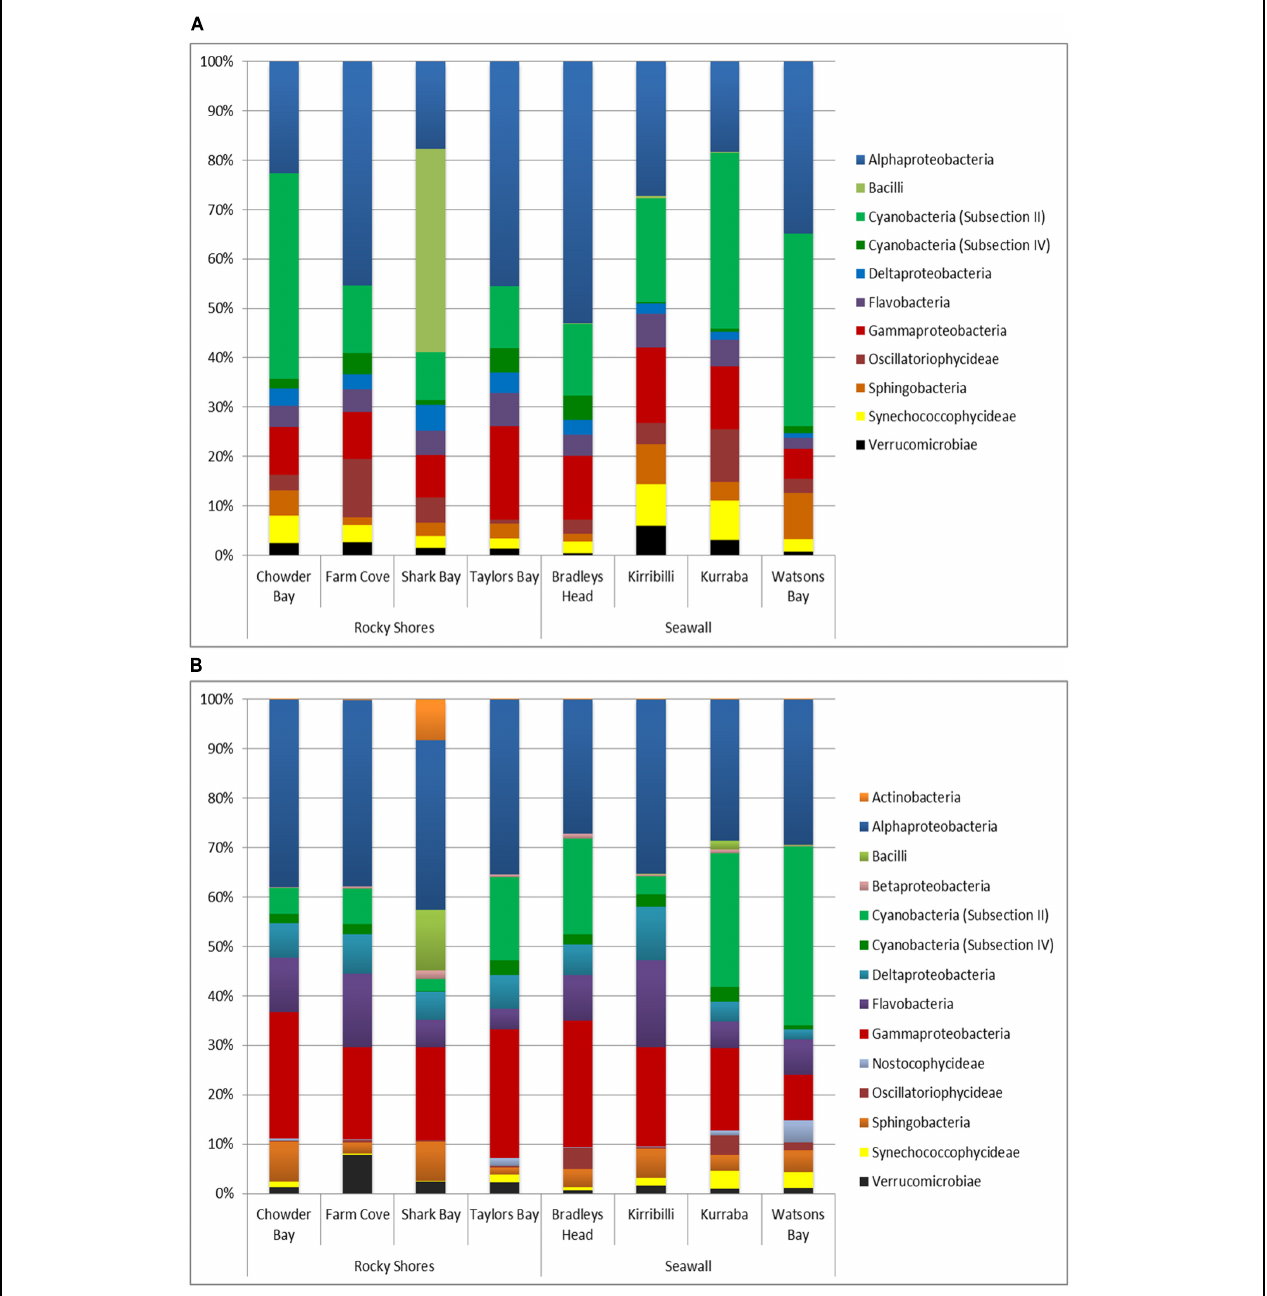
FIGURE 4 | Bacterial dominance grouped by Class sampled directly from natural rocky shores and artificial seawalls ((A) Plots) and from substrate experimentally deployed in the habitat ((B) Recruitment